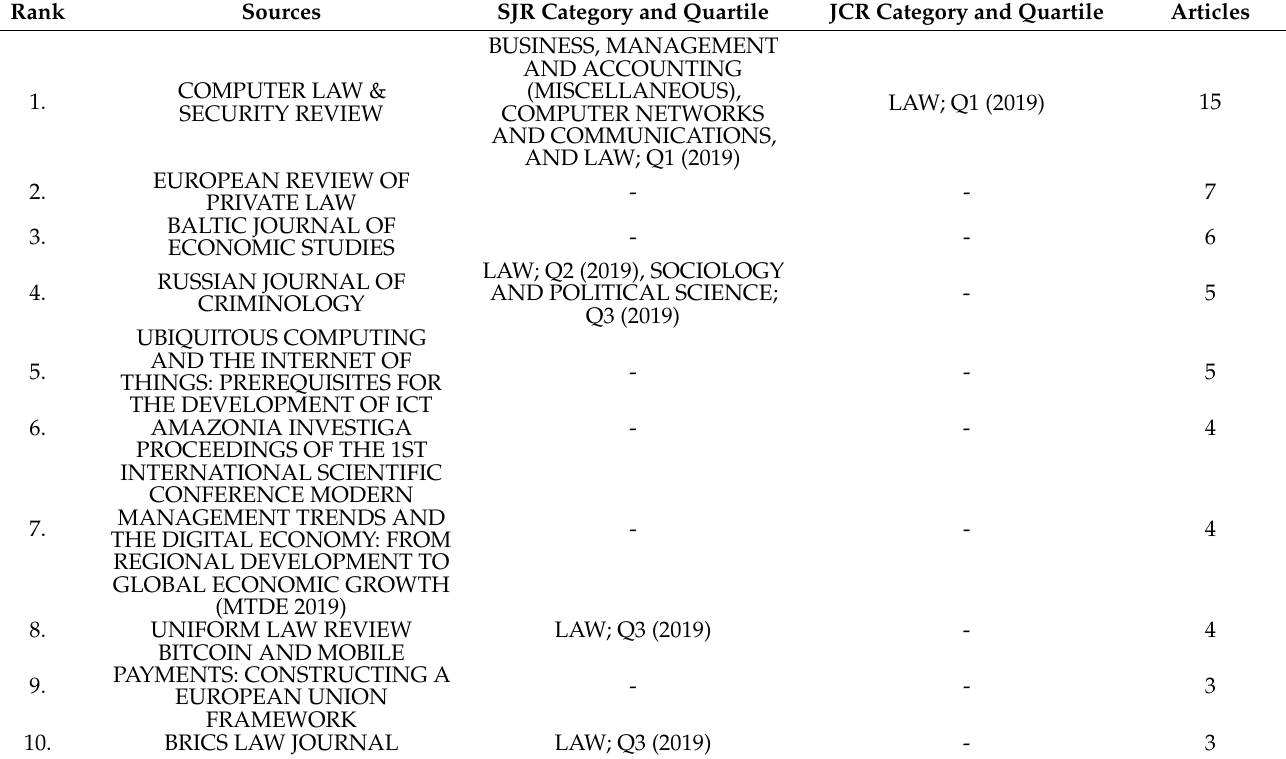
Table 3. Top 10 Most relevant sources (2015–2019).